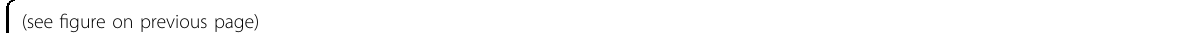
Fig. 1 System-level analysis and PBMC-based gene signatures show association with SARS and COVID-19. A Schematic showing the identi fi cation of PBMC RNA gene signatures associated with disease staging, and hierarchical modeling of genes, pathways, networks, subcellular contents, cells, and disease symptoms using COVID-engine platform. This fi gure was prepared using Servier Medical Art (https://smart.servier.com)